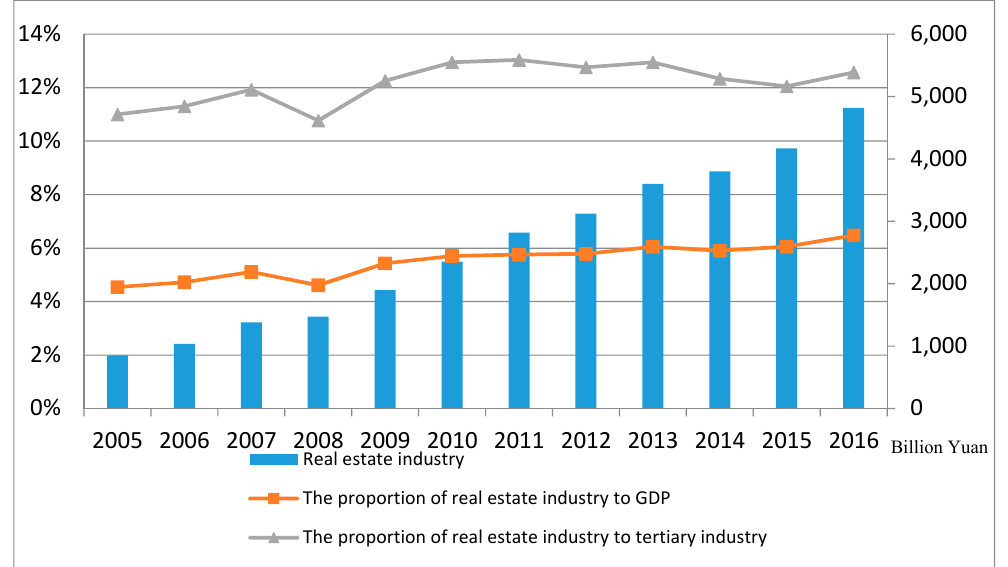
Figure 1. The Chinese real estate industry contributions to the tertiary industry and GDP in billions of Yuan. Source: China Statistics Bureau.